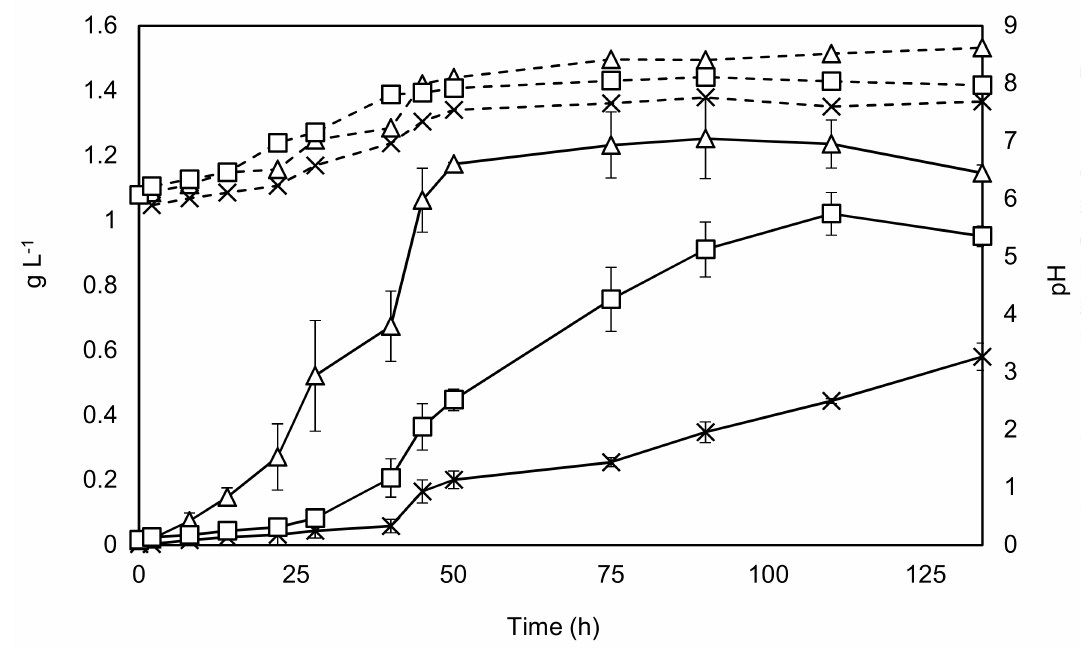
Figure 2. Growth of C. sorokiniana under phototrophic (with and without CO 2 augmentation) and mixotrophic conditions. Solid black lines represent dry weight on the primary y-axis, while dashed lines represent pH which is shown on the secondary y-axis. Triangles—growth with 2 g · L − 1 sodium acetate. Squares—growth with CO 2 addition, Crosses—no addition of carbon source, except by mixing air. Experiments were undertaken in triplicate, and the error bars show 2 standard deviations from the